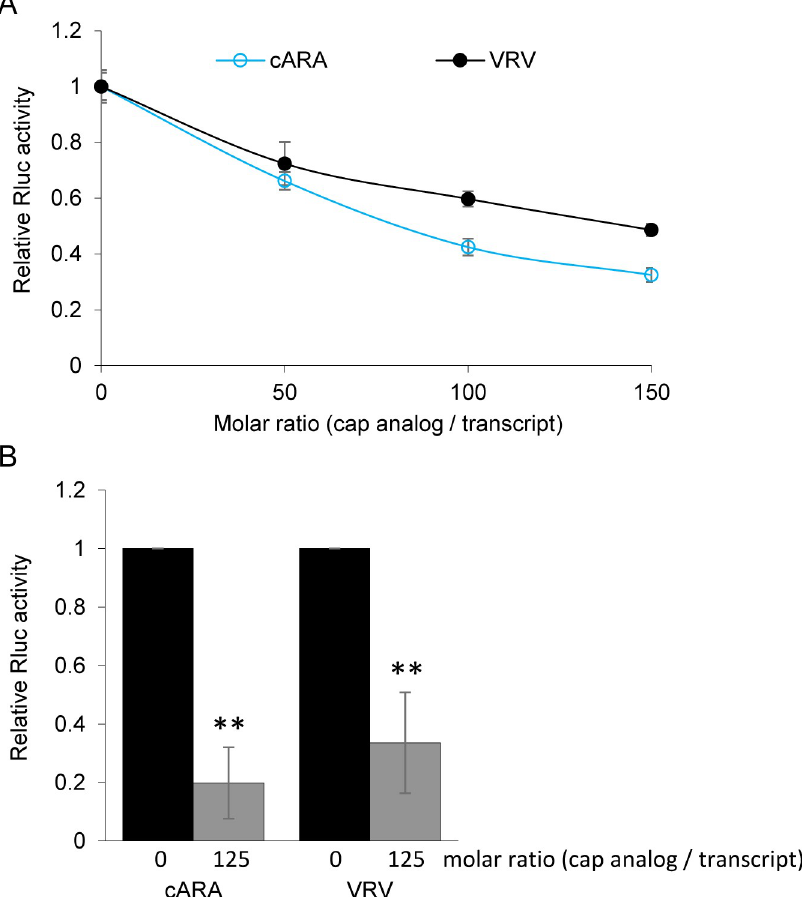
Fig 5. Cap analog inhibits translation of uncapped VRV transcripts. (A) Cap analog was added at increasing concentrations ranging from 0 to 150 picomoles per 50 μ l translation reaction volume that also contained one picomole of reporter transcripts (uncapped VRV or capped ARA) and the luminescence activity of the translation reactions was measured. Experiments were repeated four times using varying concentrations of cap and a representative result is shown. Error bars represent the standard deviation of three technical repeats. (B) Translation inhibition of uncapped VRV or capped ARA (cARA) transcripts in the presence of a 125-molar excess of cap analog. Reactions were conducted as above. Translation of 1 picomole of either transcript (VRV or cARA) was reduced significantly in the presence of 125 picomoles of cap analog ( �� , P < 0.001, Student’s t-test, two-tailed, n = 4). Results are presented as an average of four independent experiments, each with three technical repeats. Error bars represent the standard